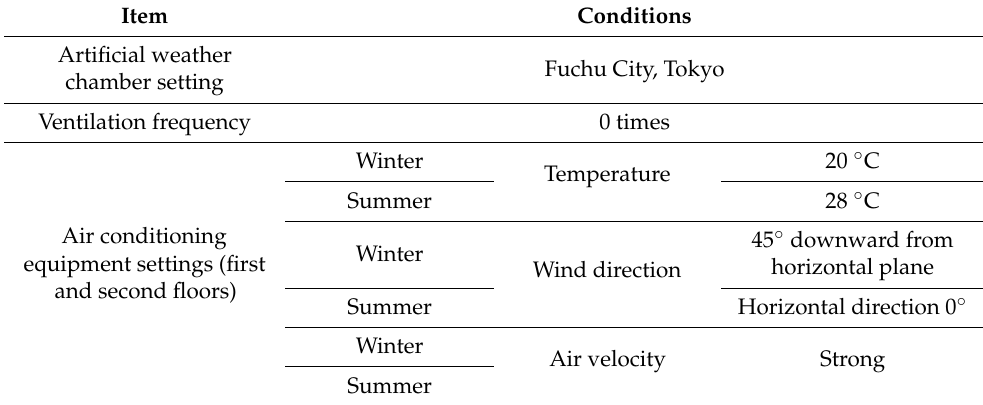
Table 2. Experimental conditions.